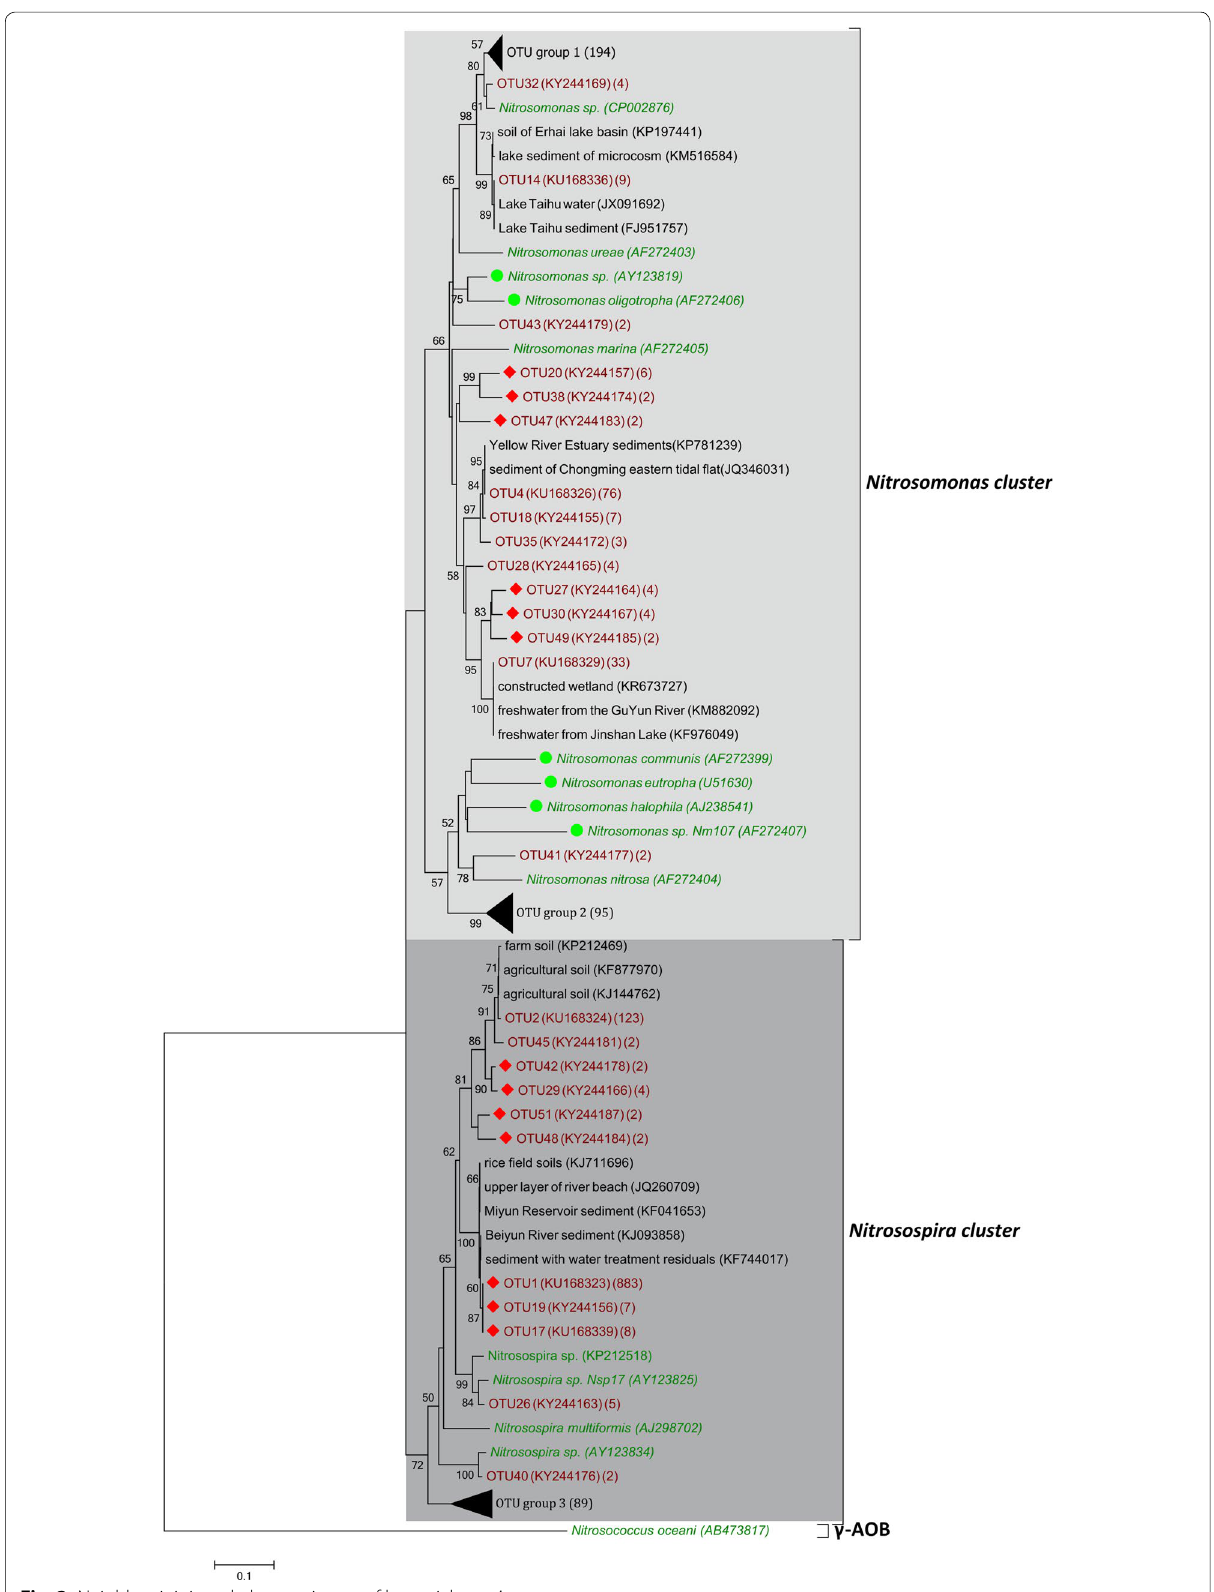
Fig. 3 Neighbor-joining phylogenetic tree of bacterial